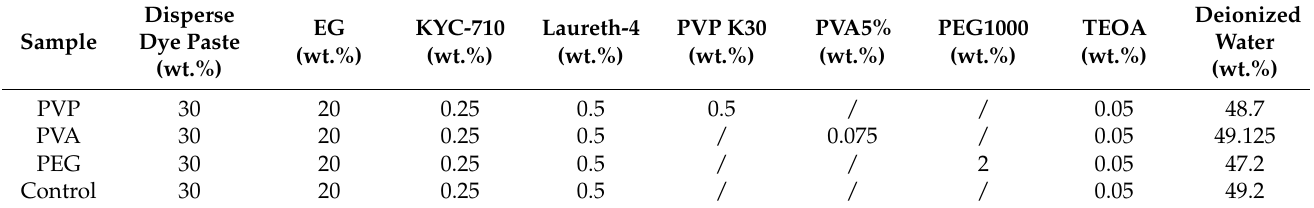
Table 1. The formulation of disperse dye